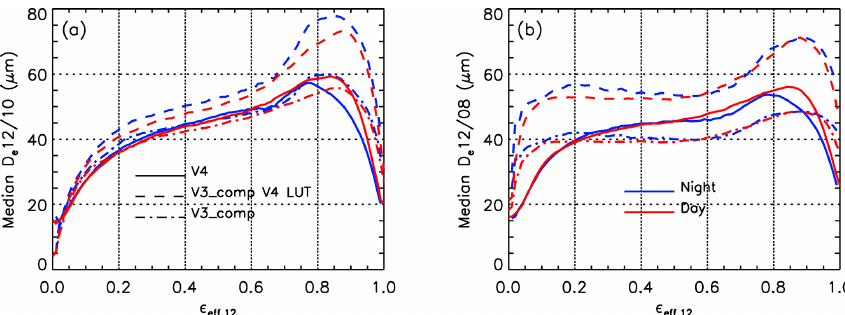
Figure 7. (a) Median D e 12 / 10 and (b) median D e 12 / 08 vs. effective emissivity at 12.05µm for the cloud population used in Fig. 6, except that both β eff 12 / 10 and β eff 12 / 08 are in the range of possible retrievals, both in V3_comp and in V4. Solid line: V4 with SCO LUT; dashed lines: V3_comp with V4 SCO LUT; dashed–dotted line: V3_comp with V3 solid column LUT. Blue: night; red: day.